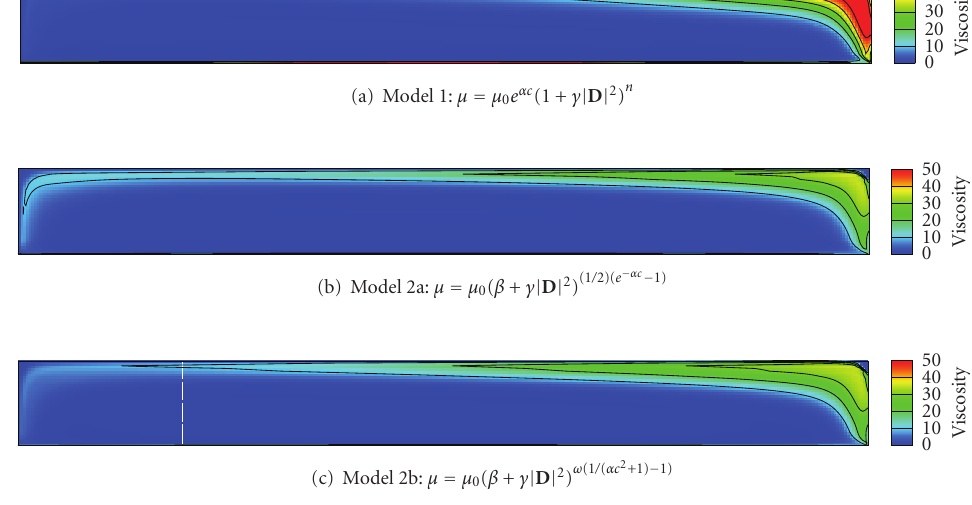
Figure 9: Viscosity